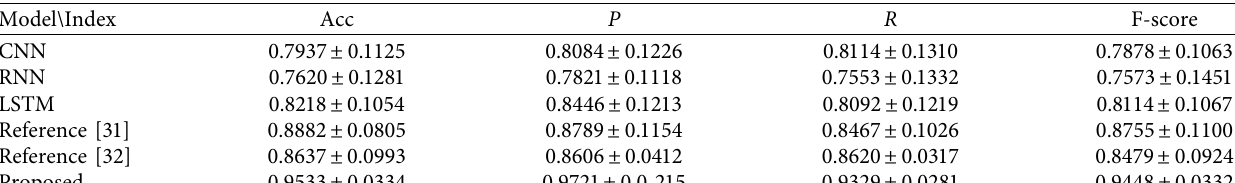
Table 4: 2-classification experimental results.